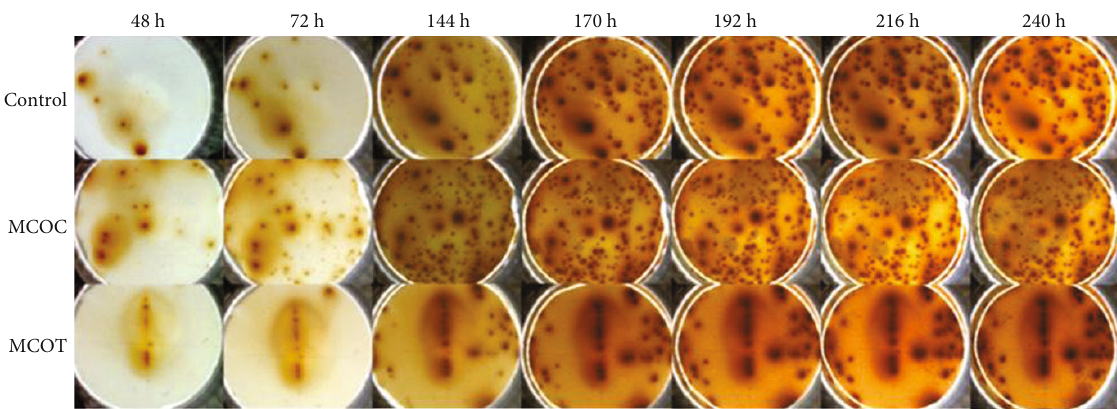
Figure 14: Control system, MCOT system, and MCOC system images with exposure hours between 48 and 240